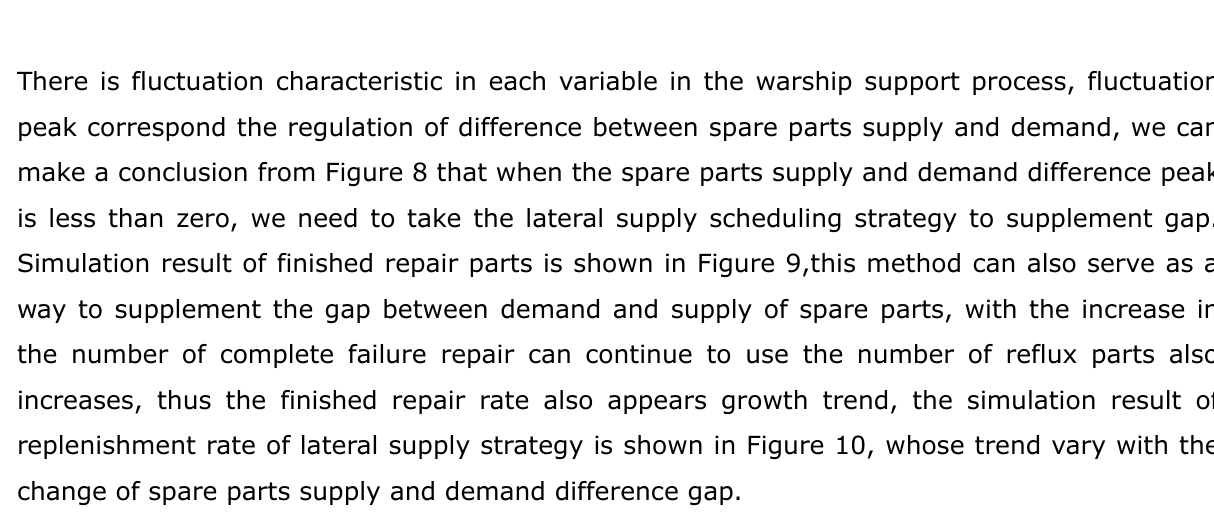
Figure 7. Replenishement amount of spare parts